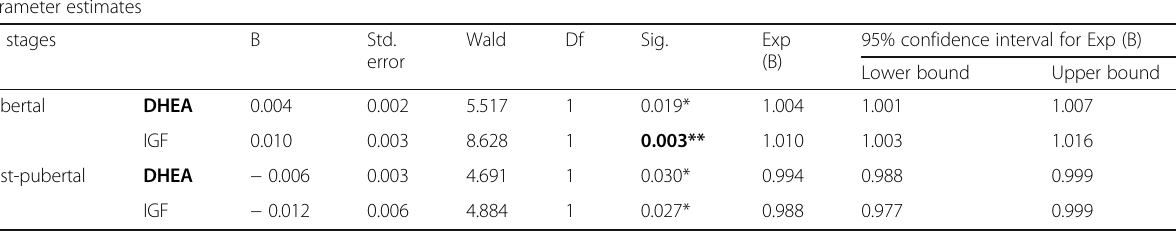
Table 6 Univariate regression analysis of relationship of IGF-1 and DHEA-S with CS stages Parameter